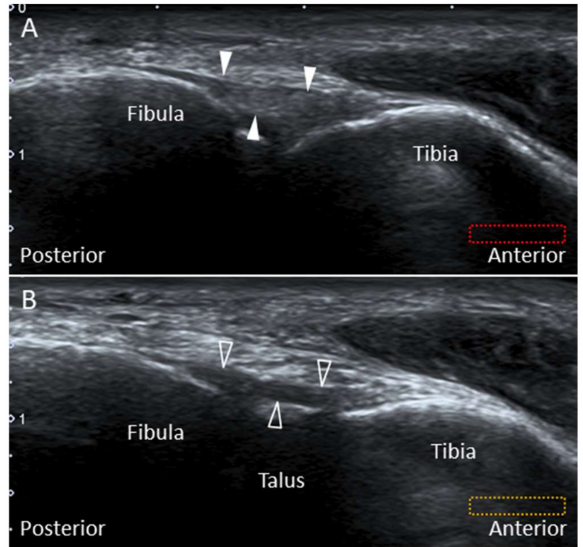
Figure 4. Imaging of the anterior-inferior tibiofibular (arrowheads) ( A ) and the Bassett’s (void arrowheads) ligaments ( B ). The di ff erent colored dashed rectangles are in accordance with the transducer positions in Figure